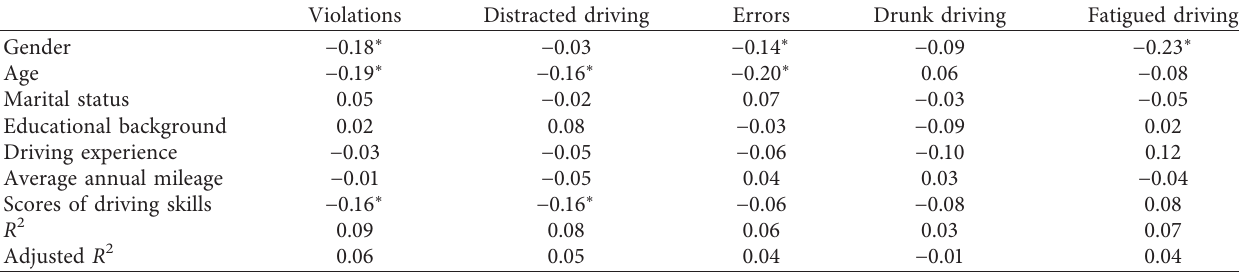
Table 3: Standardized β of multiple linear regression with five factors as the dependent variable.